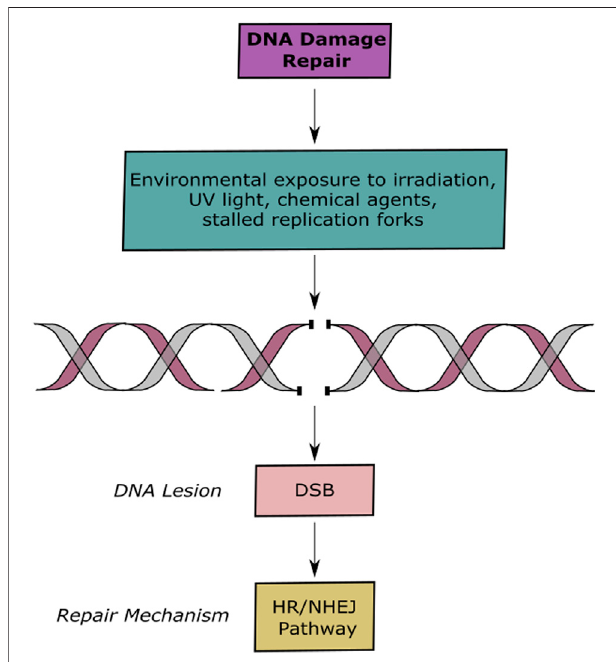
FIGURE 1 | DNA Lesions and Repair Pathways. Schematic representation of DNA damage and repair. Exogenous and endogenous agents induce DSBs, which are repaired by the HR or NHEJ